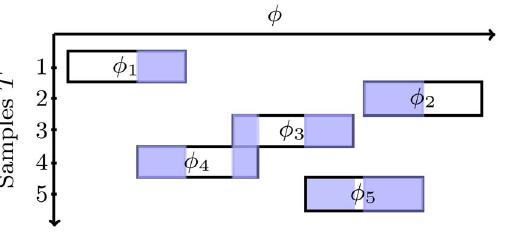
Figure 6. Reference set adjustment. Each of the training samples contributes to the reference set on local interval w [ ½ w est w conf (cid:2) . For illustration purposes, angles with multiple representations are colored. Acquisition of unlabeled training images is usually trivial, thus an arbitrary number of feature representations can be obtained at every angle.